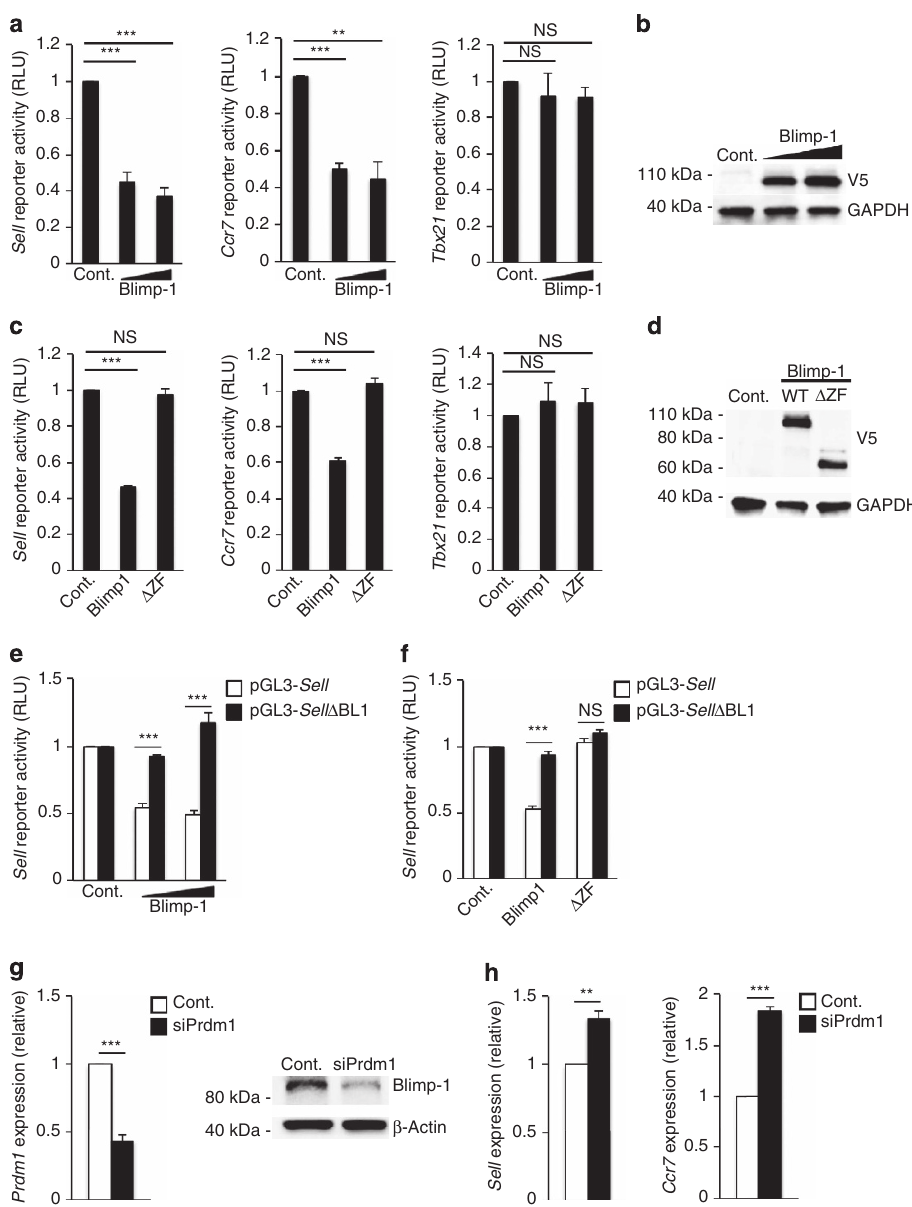
Figure 2 | Blimp-1 represses the CD4 þ T CM genes Sell and Ccr7 . ( a , c , e , f ) EL4 Tcells were transfected with the indicated promoter–reporter constructs in combination with a wild-type Blimp-1 expression vector, a Blimp-1 mutant incapable of binding to DNA ( D ZF), or an empty vector control (mean of n ¼ 3 ± s.e.m.). In e and f , EL4 T cells were transfected with either a wild-type Sell promoter–reporter or a Sell promoter–reporter lacking the predicted Blimp-1 DNA-binding elements (pGL3- Sell D BL1). Luciferase promoter–reporter values were normalized to a renilla control and expressed relative to the control sample for each experiment (mean of n ¼ 4 ± s.e.m.). ( b , d ) Wild-type and mutant Blimp-1 protein levels were measured by immunoblot